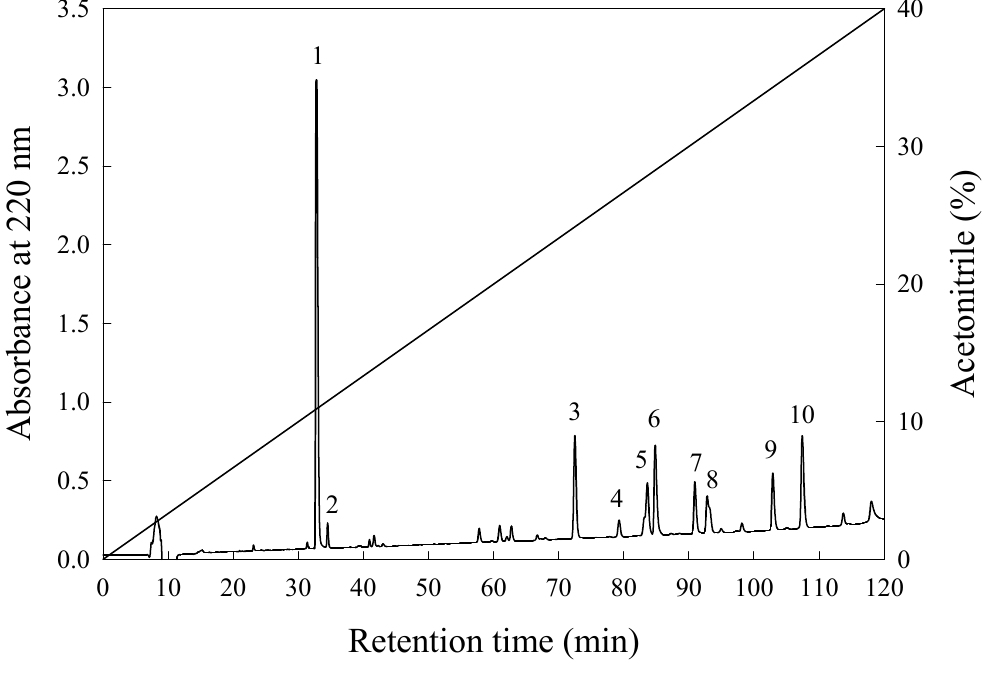
Figure 2. Elution profile of fraction F from Figure 1 by reversed phase-high performance liquid chromatography (RP-HPLC). Column: Synergi 4u Hydro-RP 80A (10 × 250 mm 2 ; particle size: 4 µm; Phenomenex); elution A (deionised water containing 0.1% trifluoroacetic acid) and B (100% acetonitrile containing 0.1% trifluoroacetic acid); mobile phase: a linear gradient from 0% to 40% of B within 120 min; flow rate of 1.5 mL/min at room temperature, and detection at 220 nm.